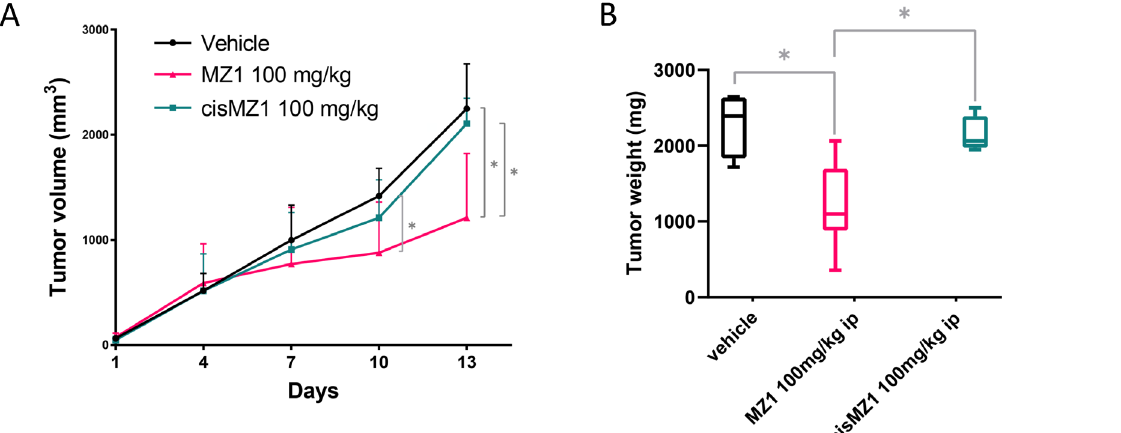
Figure 3. Antitumor in vivo activity of MZ1 in an ABC DLBCL model. Mice were treated with vehicle (i.p., 3 days ON/4 days OFF), MZ1 (100 mg/kg i.p., 3 days ON/4 days OFF), cisMZ1 (100 mg/kg, i.p., 3 days ON/4 days OFF). (A) Lines show median values per timepoint with the corresponding upper interquartile range. Y-axis, tumor volume in mm 3 ; X-axis, days of treatment. (B) Tumor weight represented at autopsy illustrated as Tukey box plot showing the median and the 25-75 percentile of the treatments. * P < 0.05